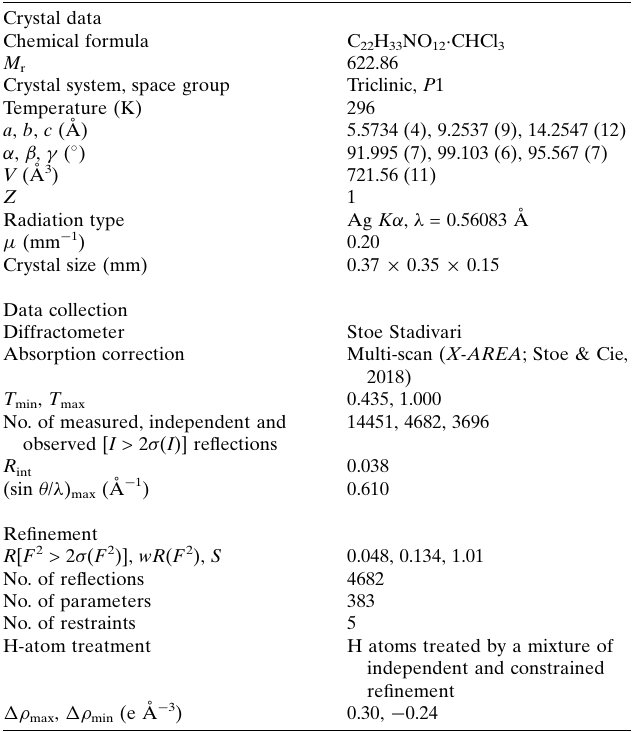
Table 2 Experimental details. Crystal data Chemical